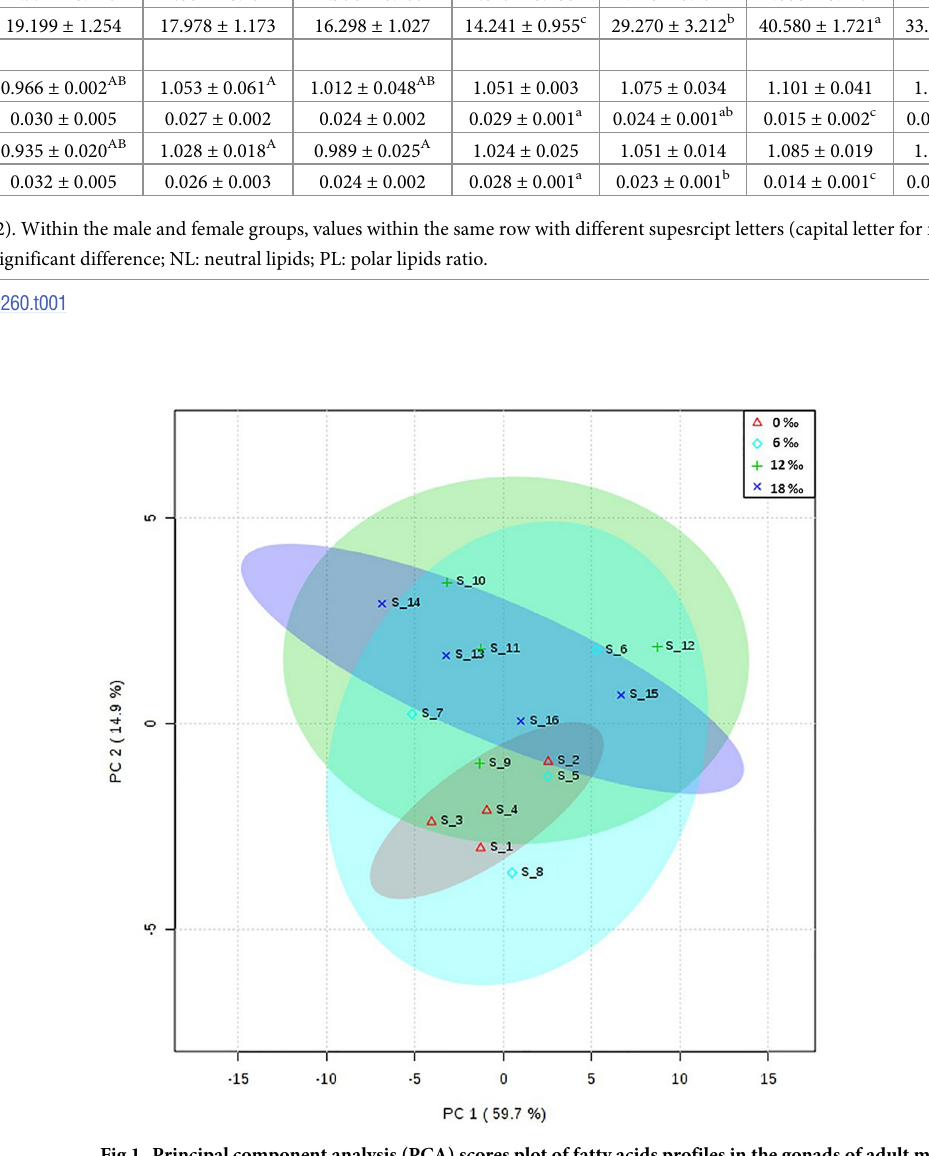
Fig 1. Principal component analysis (PCA) scores plot of fatty acids profiles in the gonads of adult male E . sinensis